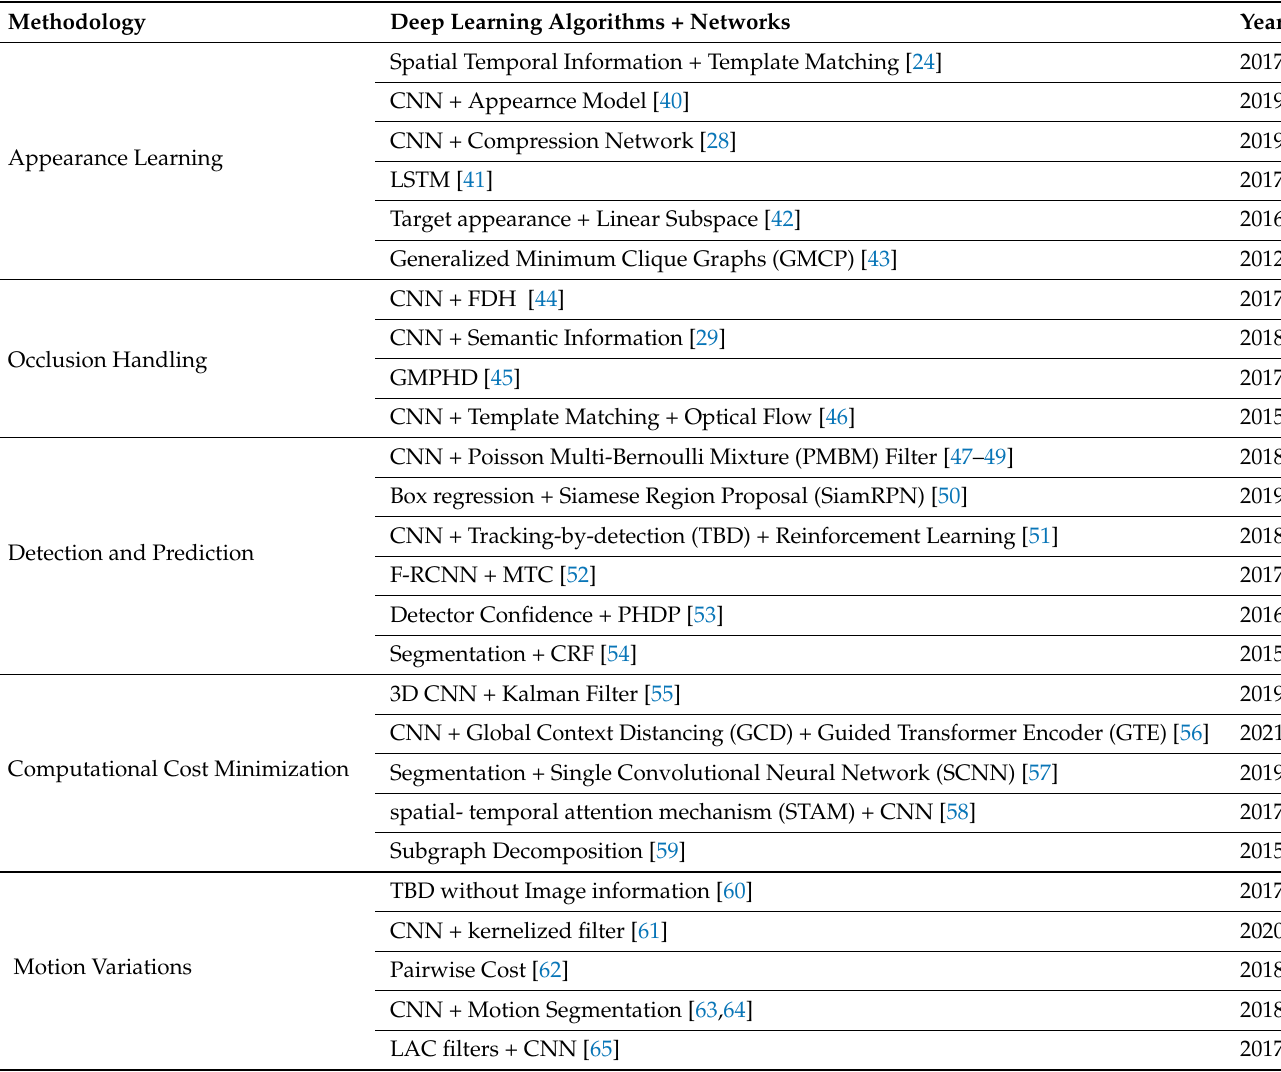
Table 2. Common MOT methods and their corresponding